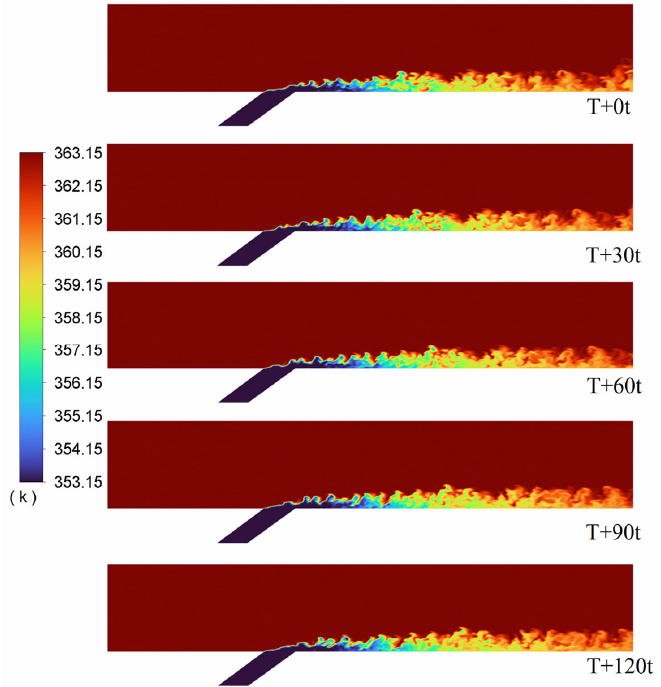
Figure 12. Instantaneous temperature distribution at different times on the central section of Case 2.